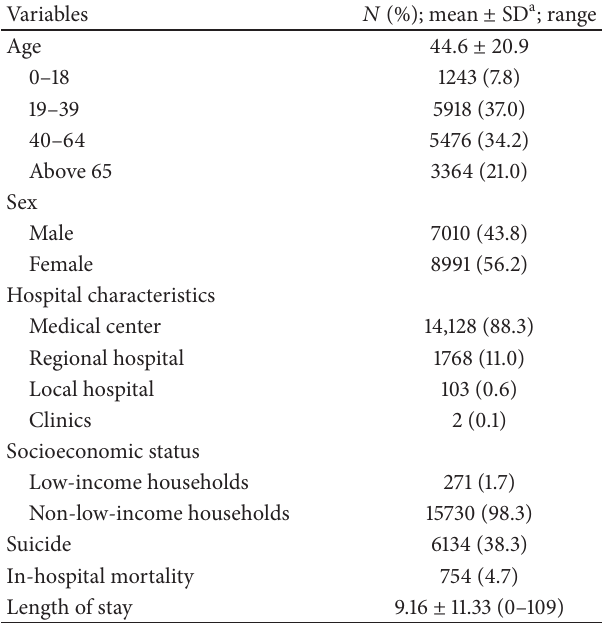
Table 1: Demographic data of corrosive injury patients, 1996–2010, 𝑁 =